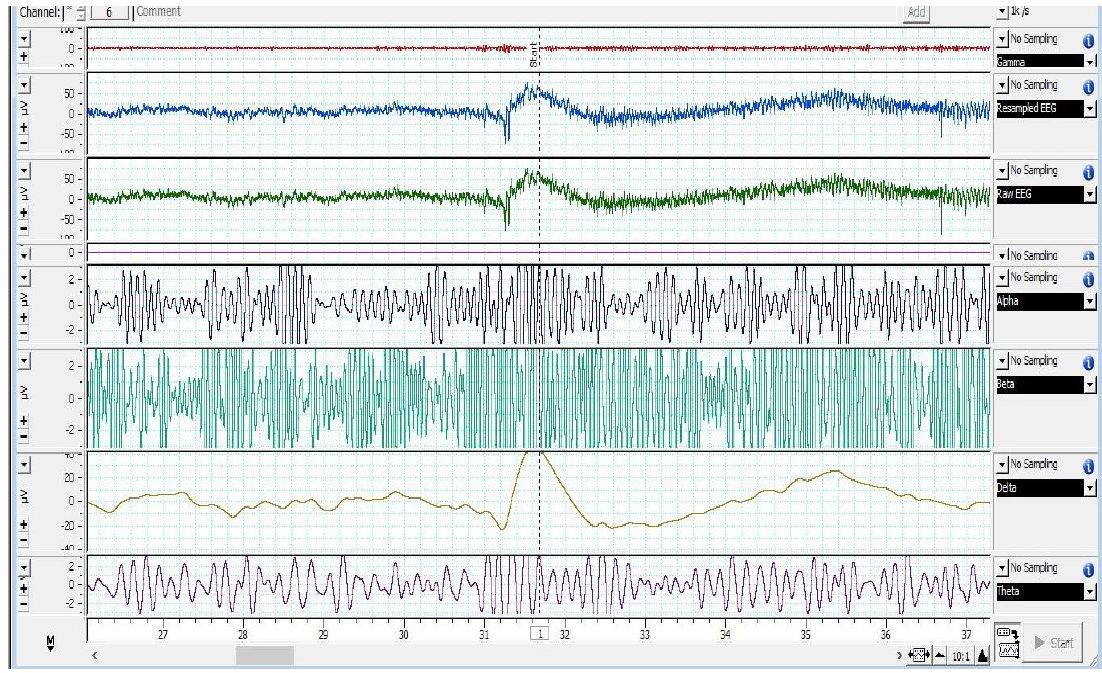
Figure 2. EEG spectrum of cattle at baseline.